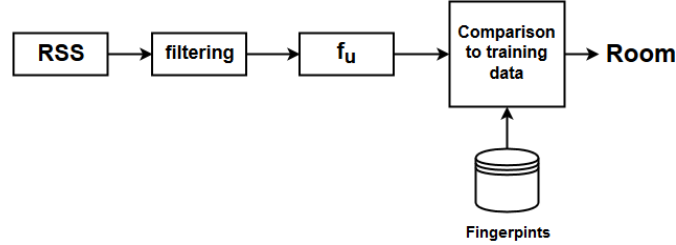
Figure 4. Block diagram describing the room estimation